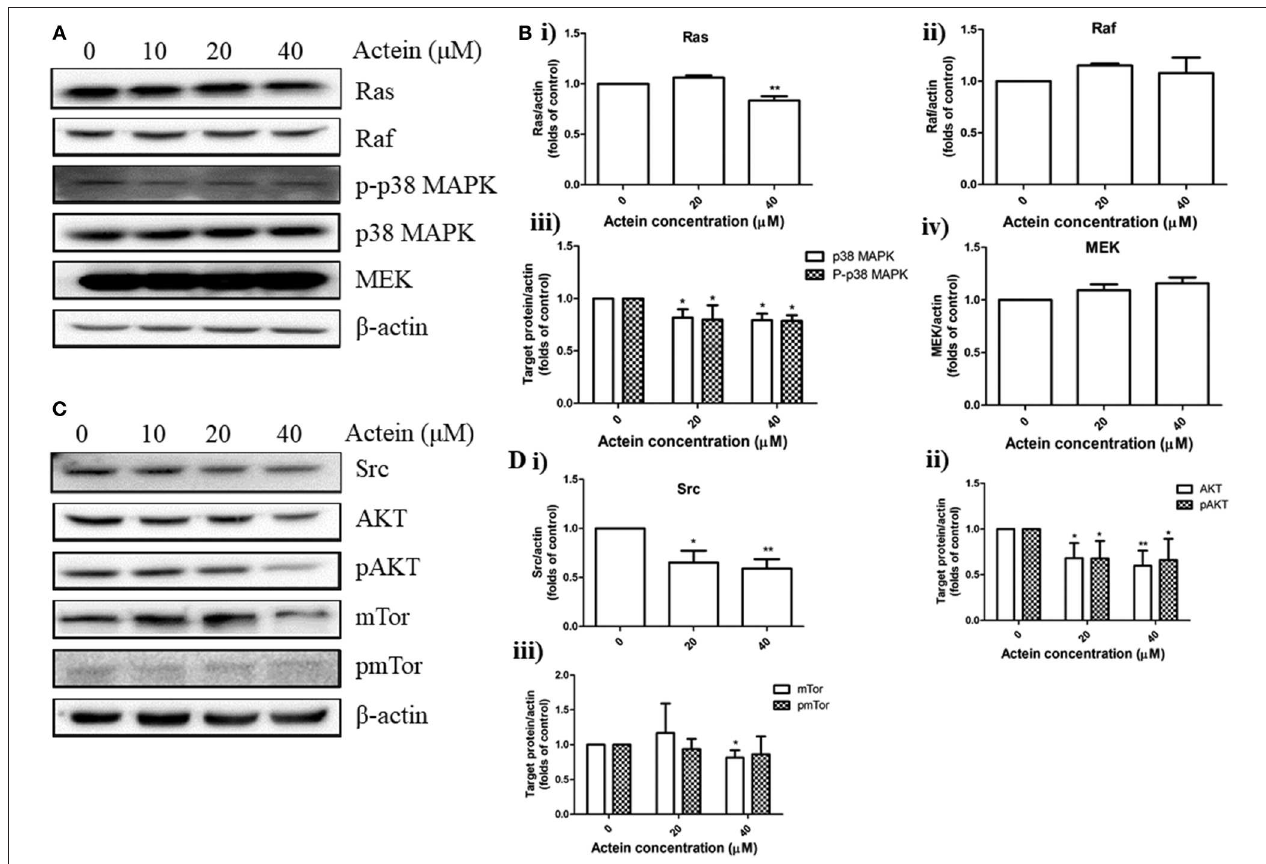
FIGURE 4 | Effects of actein on the expression of proteins in various signaling pathways in MDA-MB-361 cells. (A,C) Representative Western blots showing the expressions of Ras/Raf/MAPK and AKT/mTor signaling pathways related proteins in MDA-MB-361 cells. (B,D) Bar charts showing the results of the protein expression of Ras, Raf, p38MAPK, pp38MAPK, Src, AKT, pAKT, mTor, and pmTor using Western blot analysis, which were normalized with corresponding β -actin protein expression and expressed as fold of control (mean + SD of four independent experiments). Differences among the treated and vehicle treated control groups were determined by One-way ANOVA. * p < 0.05 and ** p < 0.01 as compared to control